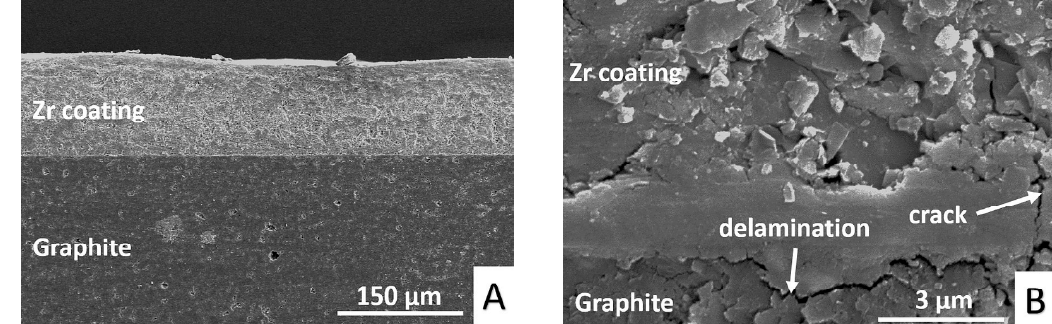
O + 20 ml HF + 1 ml 2